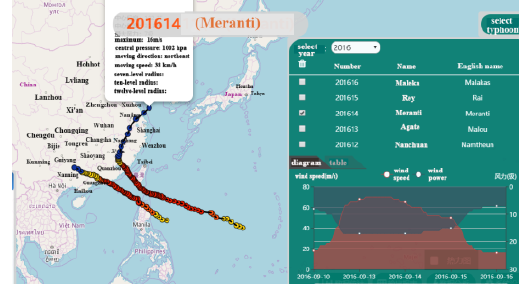
Figure 4. The detailed information of typhoon “ Meranti ”